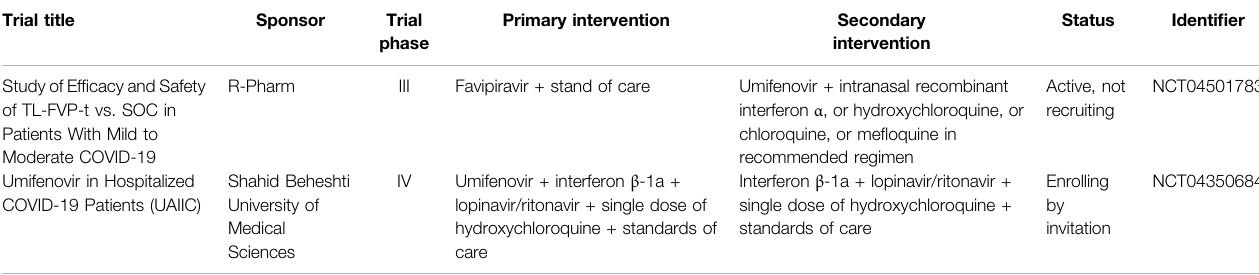
TABLE 5 | Summary of clinical trials of umifenovir on COVID-19